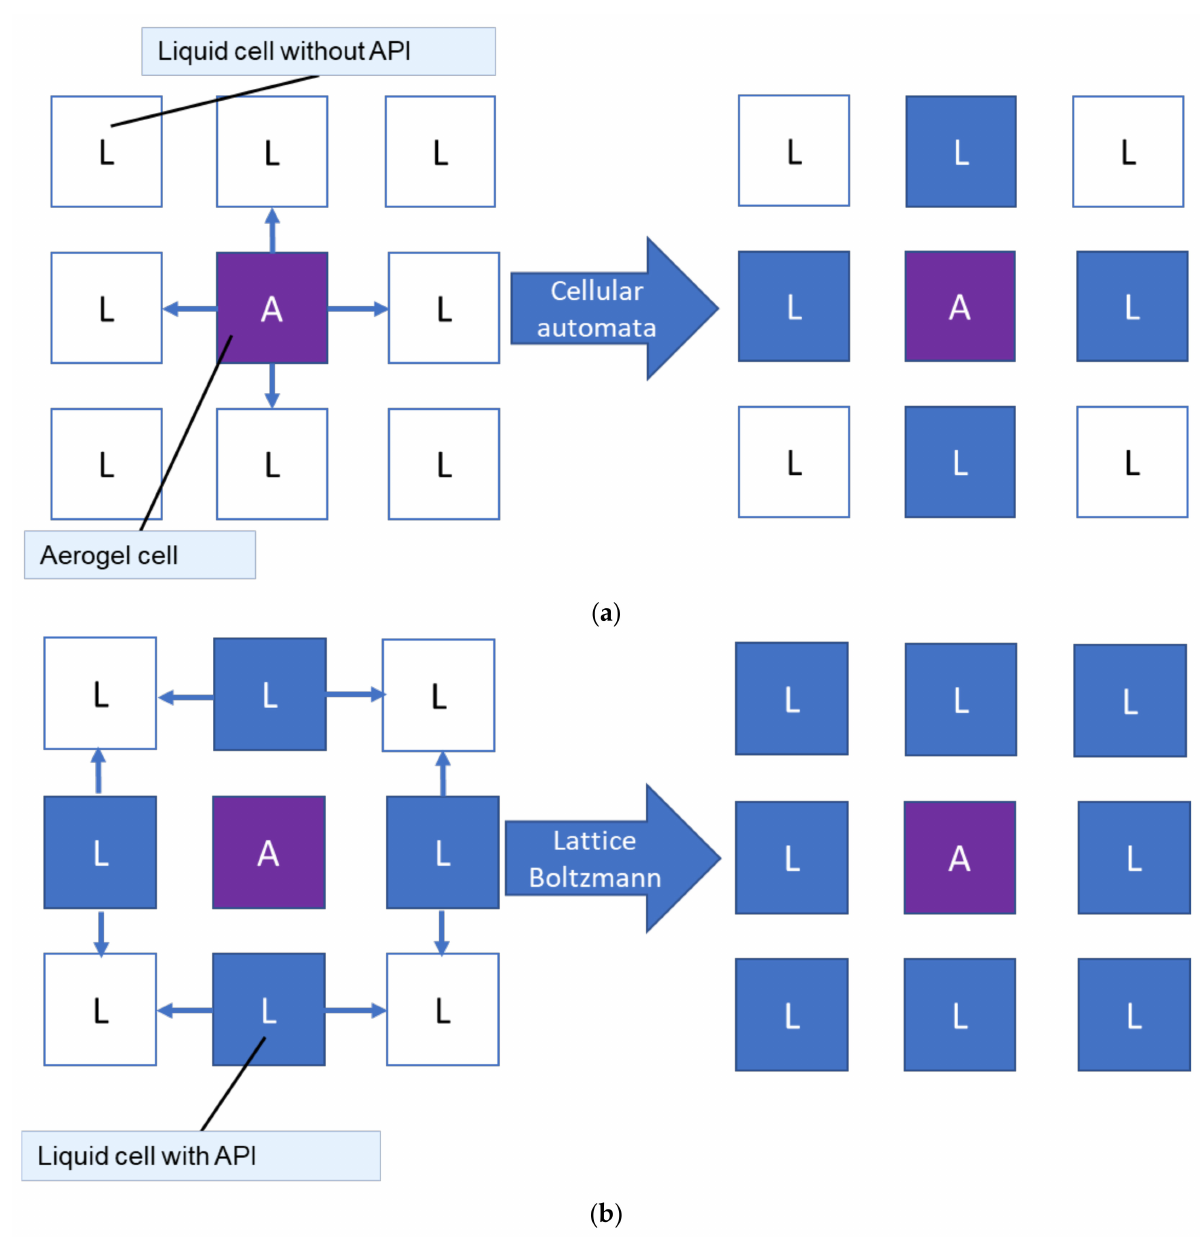
Figure 8. Processes modeling: ( a ) release; ( b ) API